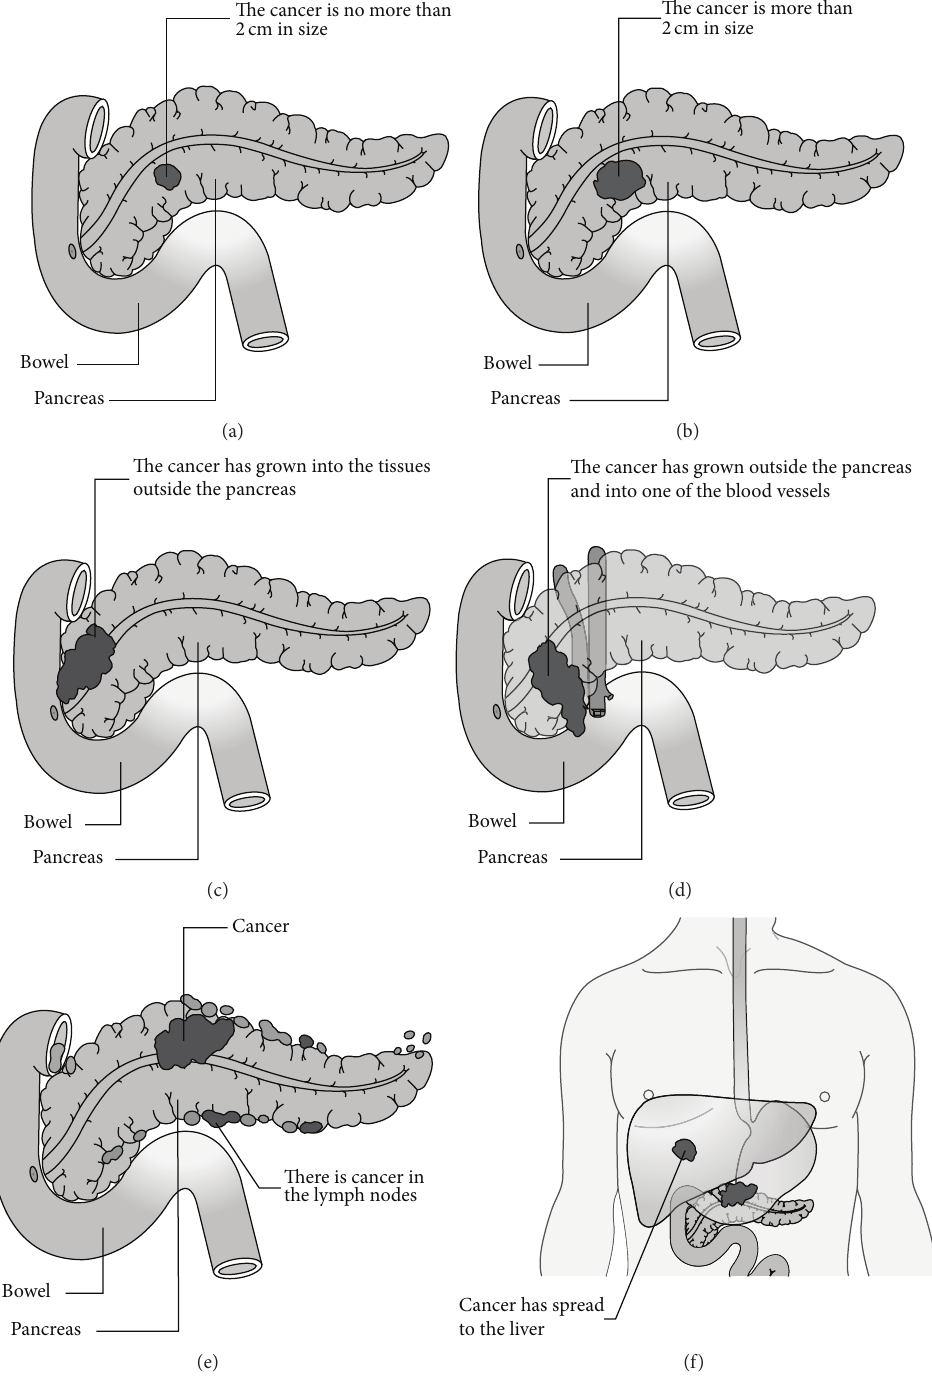
Figure 4: The UICC (Union for International Cancer Control)/AJCC (American Joint Committee on Cancer) Staging System for PC.